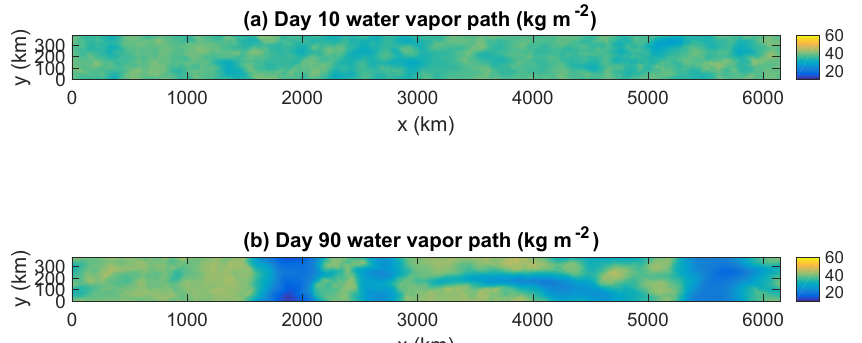
Figure 5. Daily mean water vapor path (computed from hourly averages) on day 10 (a) and day 90 (b) of the large-domain SAM simulation at T s =